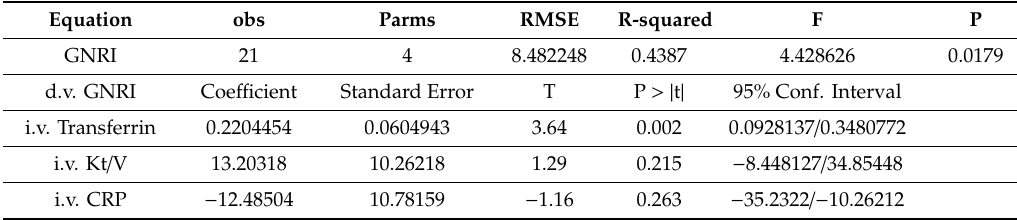
Table 8. Prediction of GNRI by transferrin, Kt / V, and